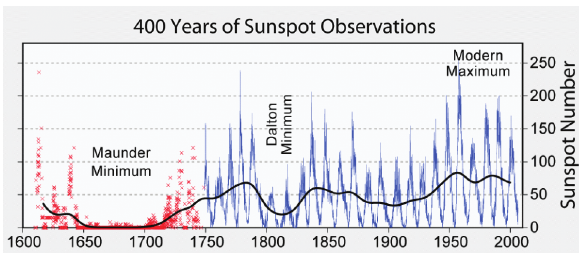
Fig. 1. Sunspot observations